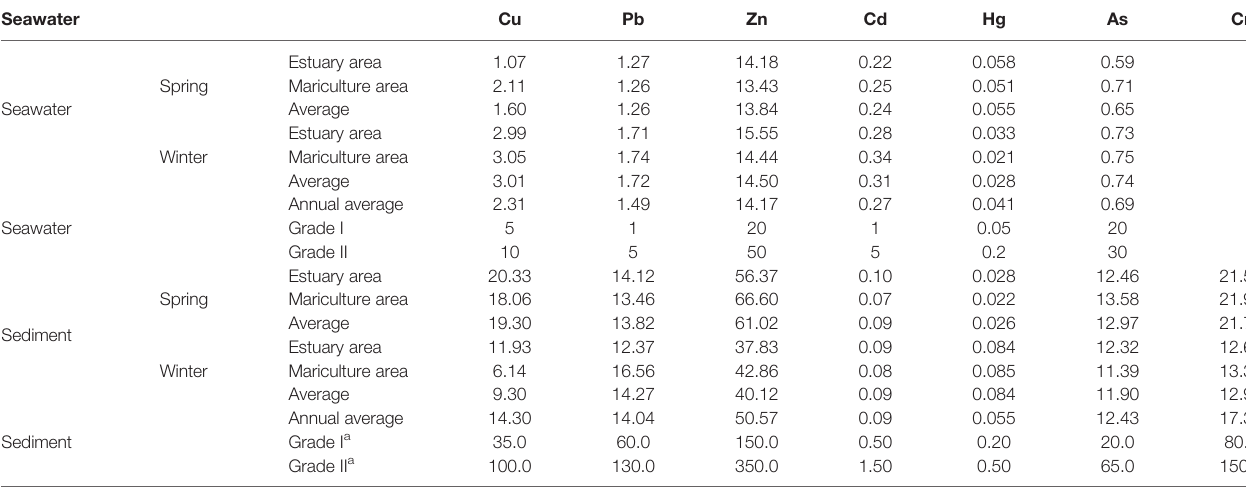
TABLE 2 | Summary of the average value of heavy metals in the seawater ( m g L -1 ) and sediment (µg g -1 ) of different areas in Qinzhou Bay during spring and